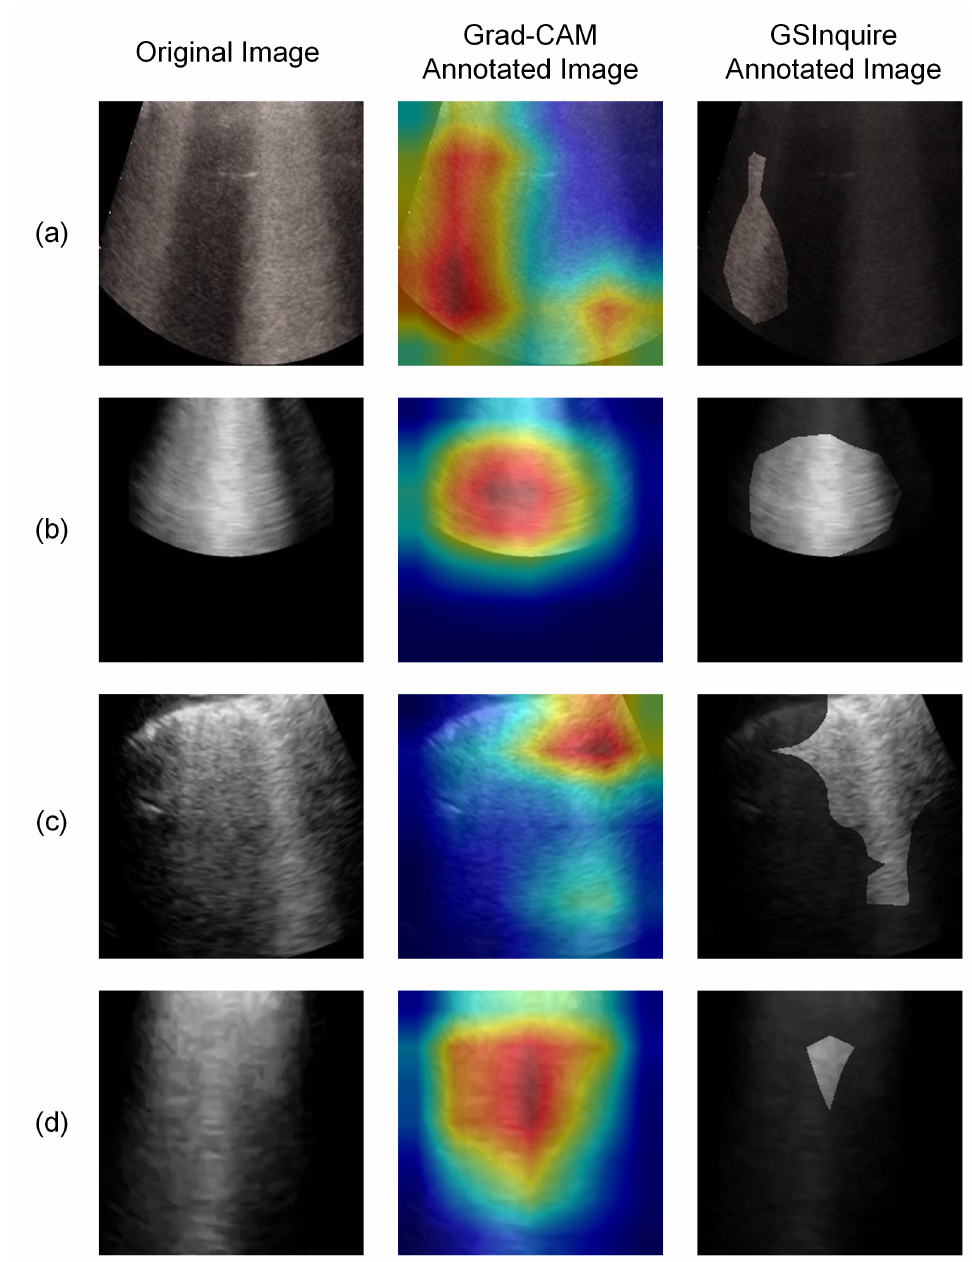
Figure 5. Four cropped COVID-19 positive examples predicted correctly with high confidence by COVID-Net USPro ( a – d ), while recognizing disease artifacts, e.g., extended